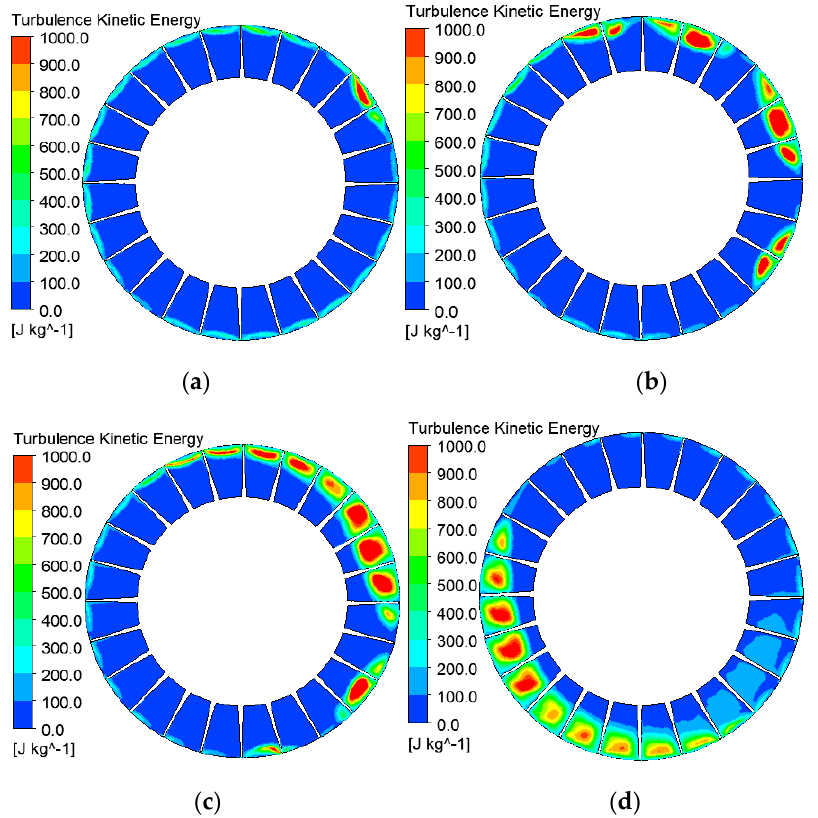
Figure 11. Turbulent kinetic energy contours of the second rotor midsection when the abnormal angle is − 6 ◦ . ( a ) Near stall inception at 8 T . ( b ) Stall inception start at 11 T . ( c ) Development of stall inception at 15 T . ( d ) Complete stall cell at 17 T .